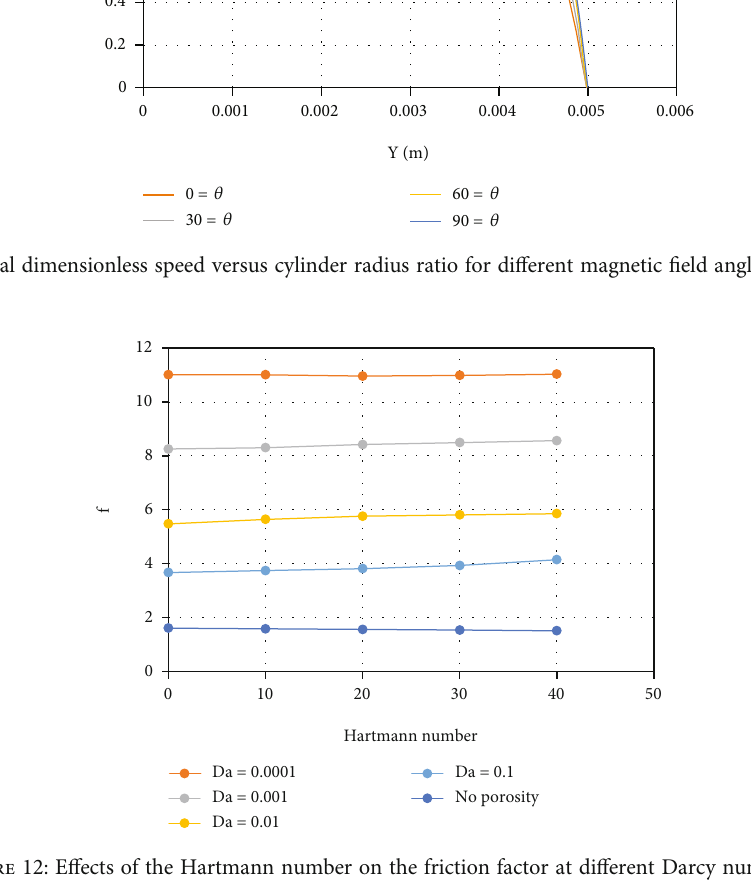
Figure 12: E ff ects of the Hartmann number on the friction factor at di ff erent Darcy